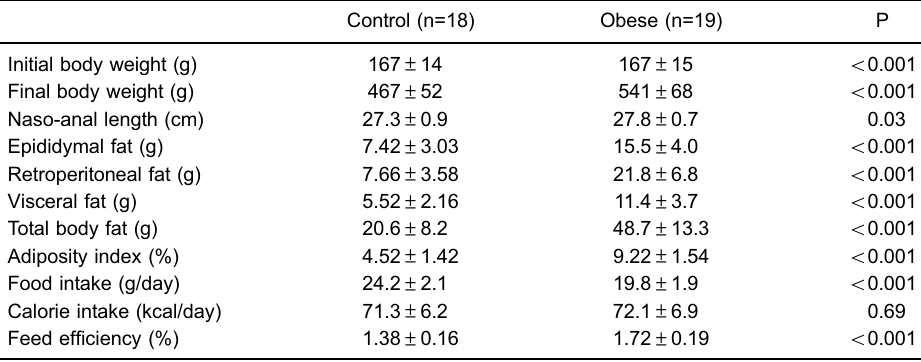
Table 1. Nutritional pro fi le.